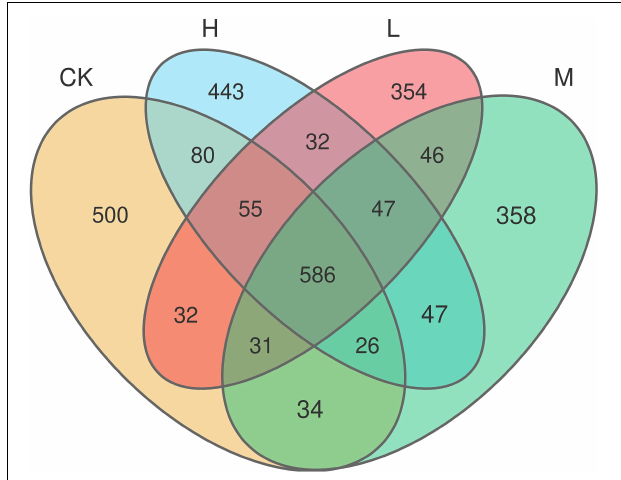
FIGURE 2 | Venn diagram analysis representing the total and unique number of OTUs in each